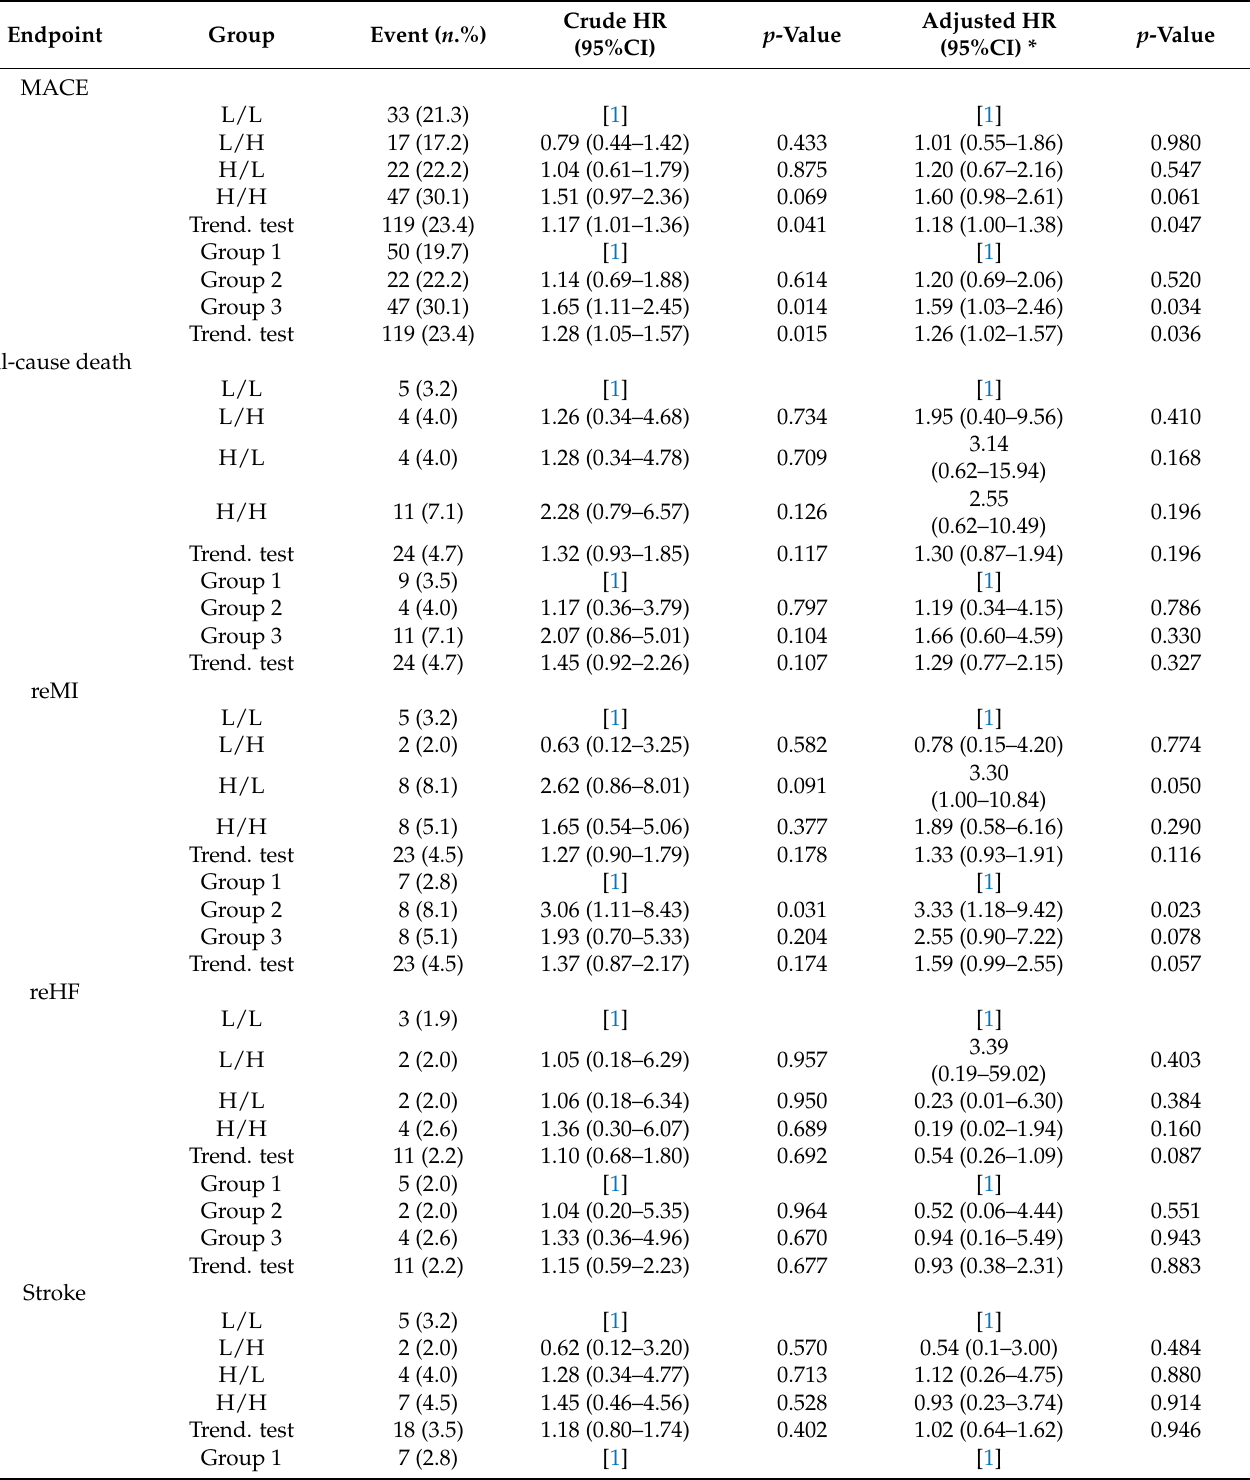
Table 3. Association between TMAO levels of V1 and V2 and all